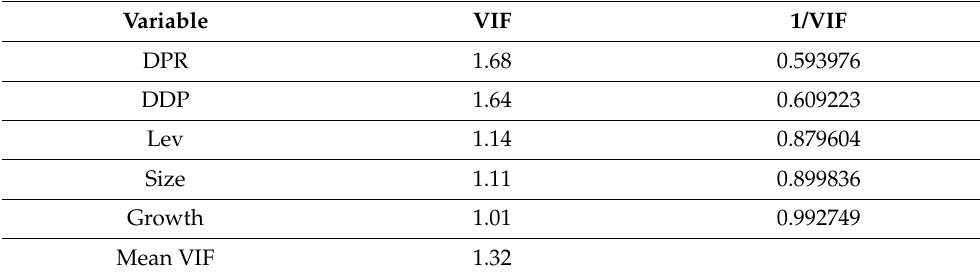
Table 3. Result for multicollinearity